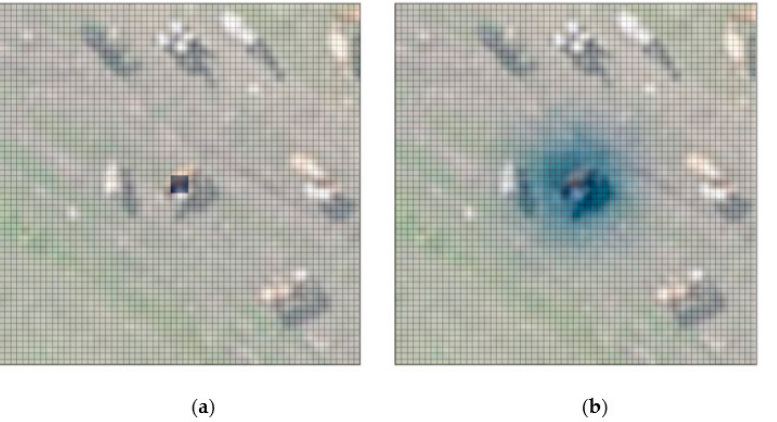
Figure 10. Schematic diagram of sampling on an image. ( a ) A schematic diagram of sampling after only one standard convolution; ( b ) a schematic diagram of sampling after CHDC with the sampling area larger, and the associated information around the object can be obtained.